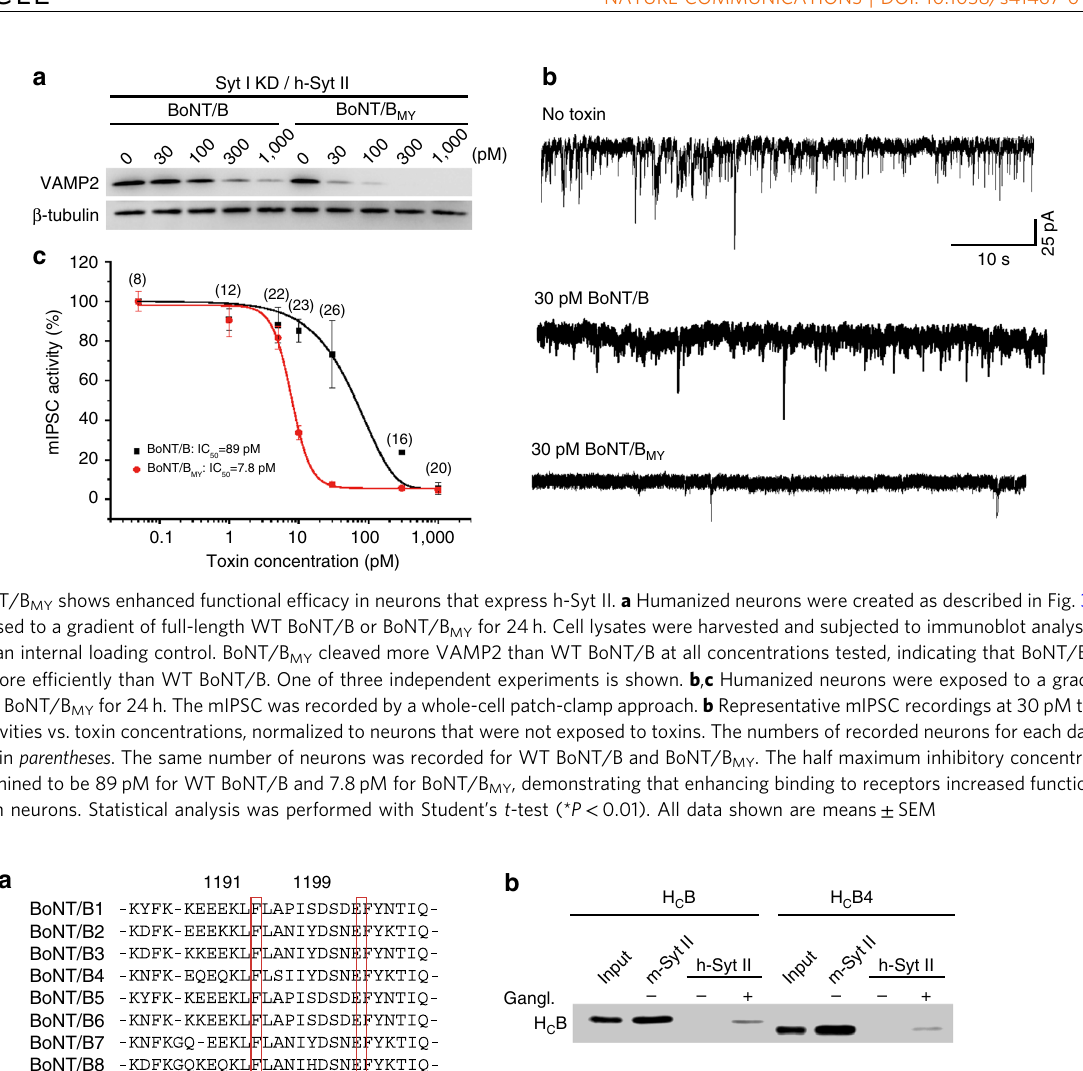
Thus, knocking down (KD) Syt I leaves these neurons with no endogenous receptors. Expressing full-length h-Syt II in these Syt I KD neurons then creates “ humanized ” neurons with only h-Syt II as the toxin receptor (Supplementary Fig. 5) 18 . WT H C B bound strongly to rat neurons, mediated by Syt I in the presence of gangliosides. As expected, the binding was largely abolished after KD endogenous Syt I (Fig. 3a). Expression of exogenous full-length m-Syt II restored binding of WT H C B. Expression of exogenous h-Syt II, or a m-Syt II containing F54L mutation, resulted in much lower levels of binding of WT H C B compared to m-Syt II (Fig. 3a). In contrast, H C B MY